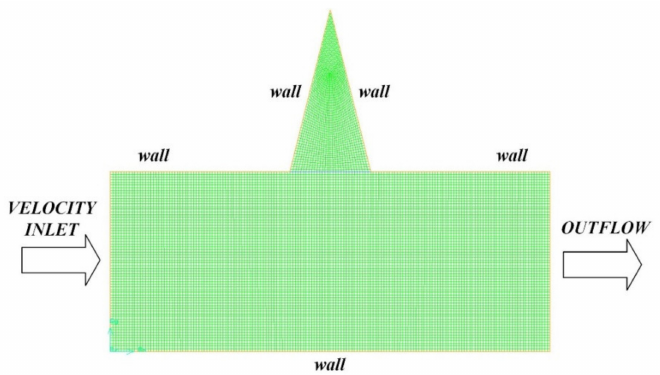
Figure 5. Boundary conditions in the simulation